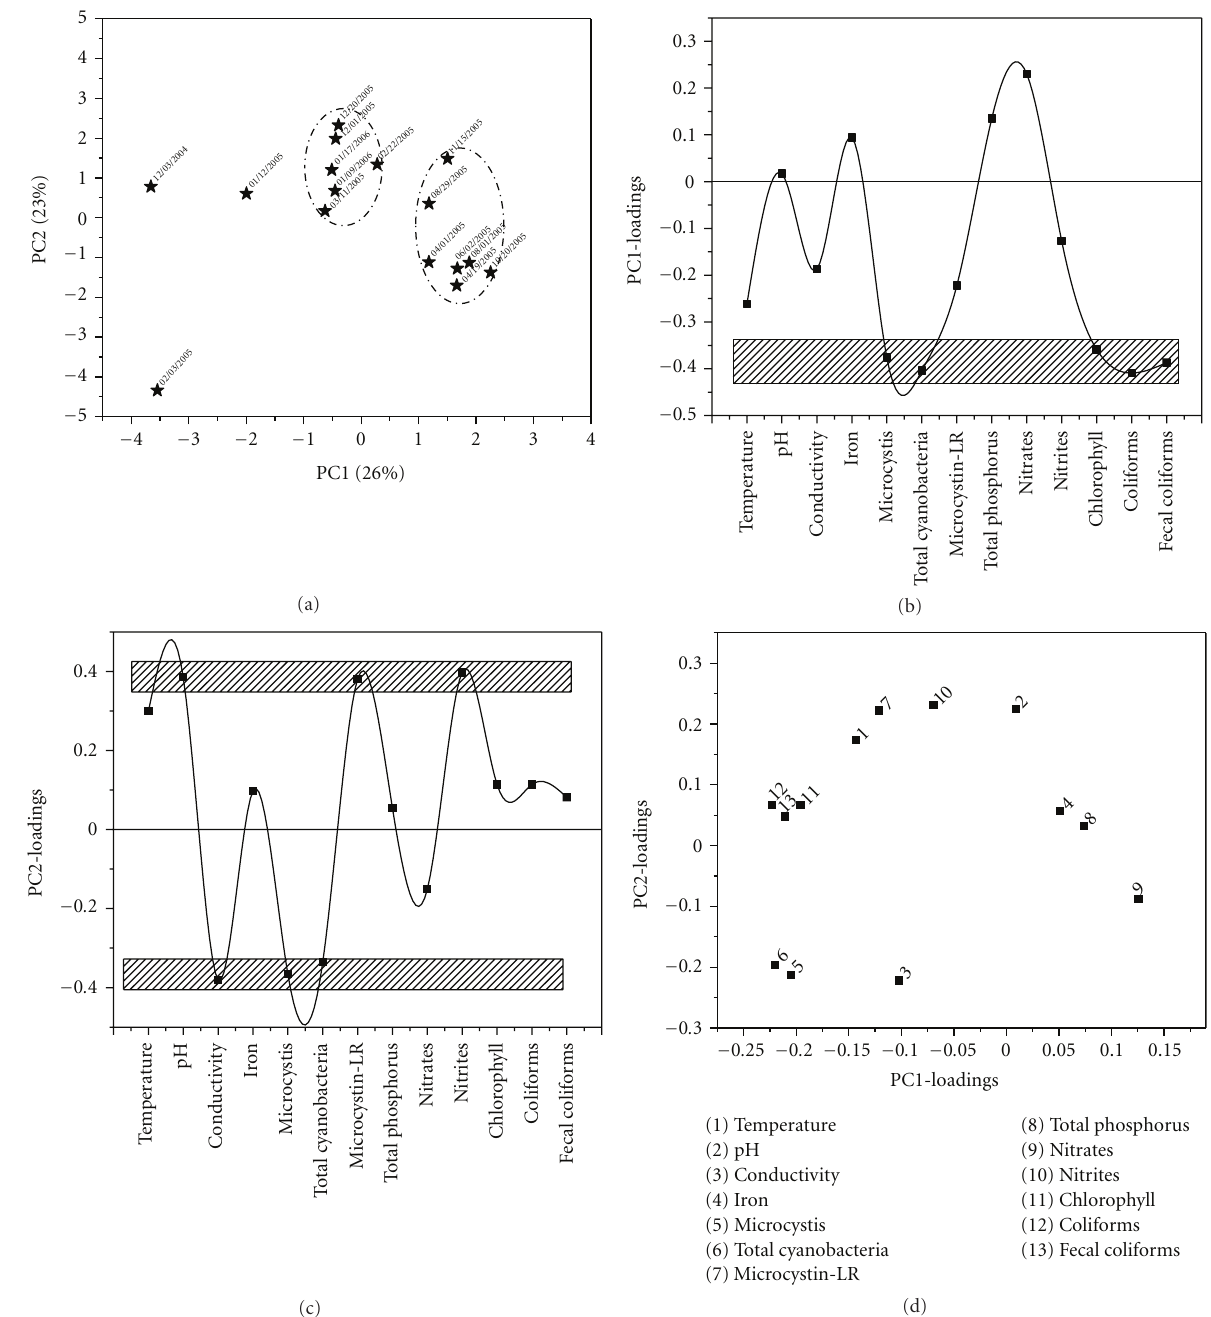
Figure 3: PCA results obtained for samples recollected from sampling point 2. (a) Two-dimensional PCA-scores plot for PC2 versus PC1, (b) and (c) correspond to one-dimensional loadings plots of PC1 and PC2, respectively, and (d) two-dimensional loadings plot.